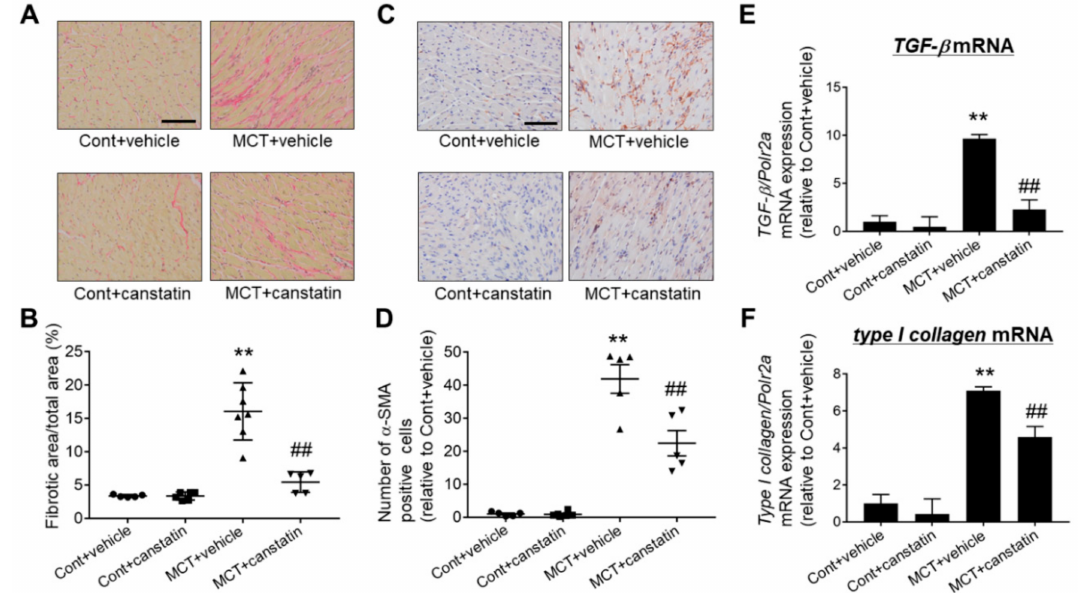
Figure 5. Canstatin improved monocrotaline-induced RV fibrosis. Four-week-old rats